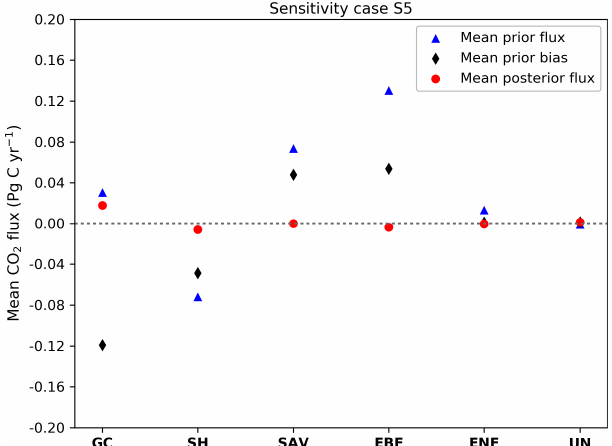
Figure 11. Prior (blue) and posterior (red) monthly-mean CO 2 flux of a ensemble of five realizations and monthly-mean prior bias (black) added to the true prior fluxes (dashed grey line). Note: re- sults are shown for adding the same biases to our five realizations.